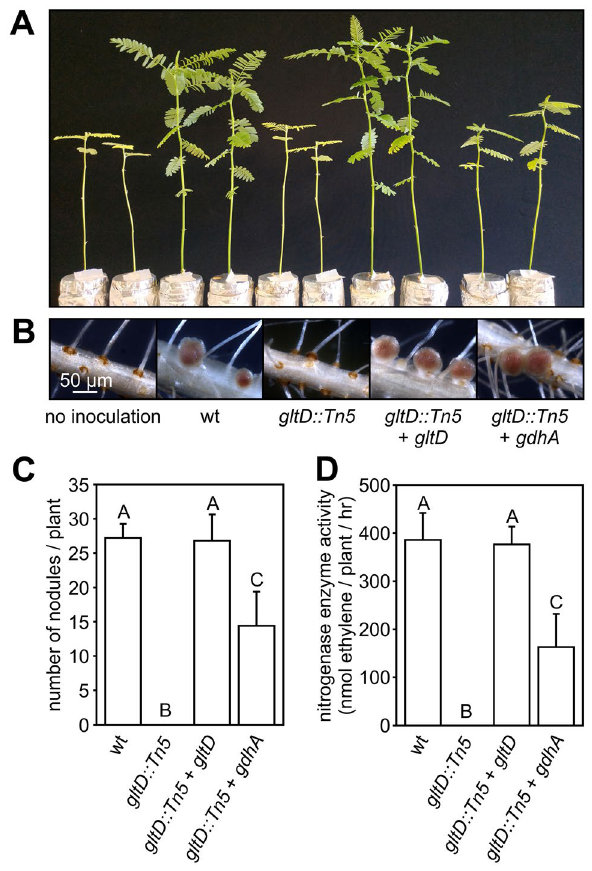
Figure 4. The Bradyrhizobium ORS285 gltD::Tn5 mutant does not induce nodules on Aeschynomene evenia (CIAT22838) plants. ( A ) Comparison of the growth of A. evenia plants inoculated with ORS285, ORS285 gltD::Tn5 , ORS285 gltD::Tn5 + gltD , and ORS285 gltD::Tn5 + gdhA . Non-inoculated plants (ni) were used as control. ( B ) Roots of A. evenia plants inoculated with ORS285, ORS285 gltD::Tn5 , ORS285 gltD::Tn5 + gltD , and ORS285 gltD::Tn5 + gdhA . Note the absence of nodules on A. evenia plants inoculated with the ORS285 gltD::Tn5 strain. ( C ) Number of root nodules on A. evenia plants inoculated with ORS285, ORS285 gltD::Tn5 , ORS285 gltD::Tn5 + gltD , and ORS285 gltD::Tn5 + gdhA , respectively. The mean number of nodules per plant (n = 5) at 21 dpi is presented. ( D ) Acetylene reducing activity of A. evenia plants inoculated with ORS285, ORS285 gltD::Tn5 , ORS285 gltD::Tn5 + gltD , and ORS285 gltD::Tn5 + gdhA at 21 dpi. The mean amount of produced ethylene per hour and per plant (n = 5) is indicated. In ( C ) and ( D ) error bars represent standard errors of the mean and letters represent conditions with significant difference according to the Tukey’s test (P <